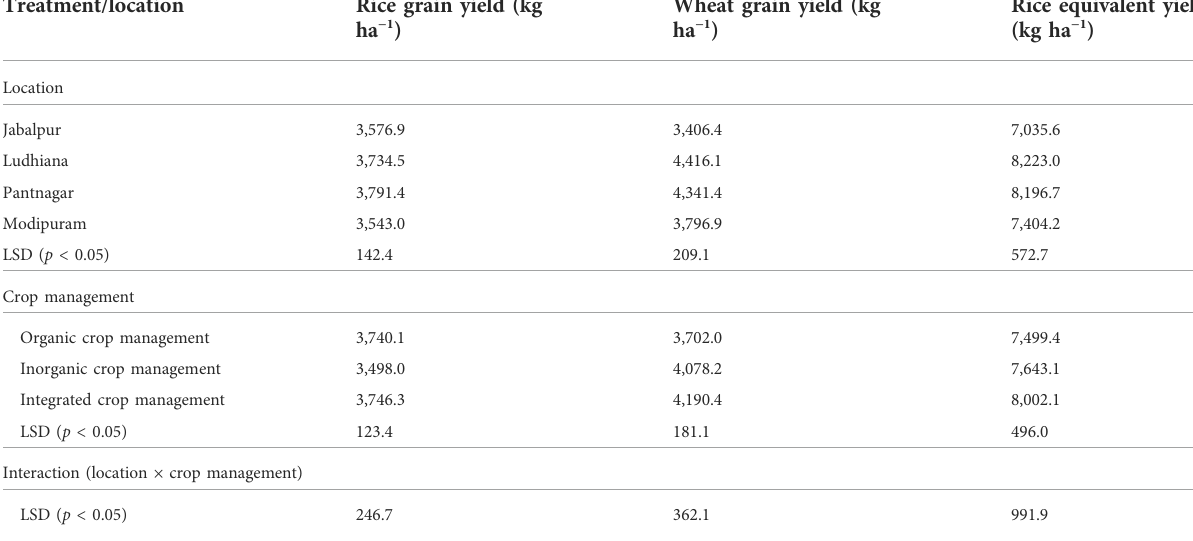
TABLE 4 Effect of spatial and crop management on grain yield and system productivity of the rice – wheat system.